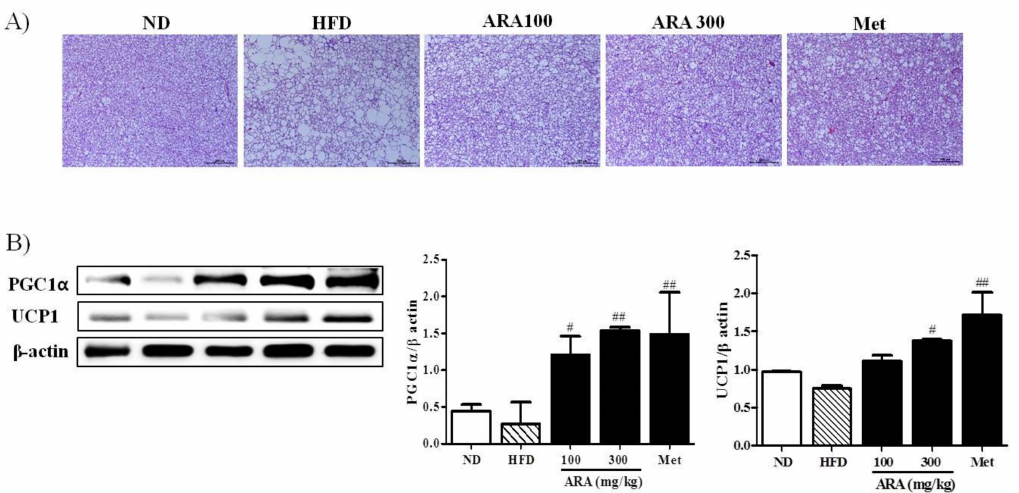
Figure 5. Effects of ARA on energy metabolism in brown fat. ( A ) hematoxylin and eosin staining in brown adipose tissues, original magnification 100 × , Scale bar: 200 µ m; ( B ) PGC1 α and UCP1 protein levels in brown adipose tissues. Results are presented as means ± standard errors of the mean (SEM) ( n = 3). ## p < 0.01, # p < 0.05 versus the high fat diet fed mice (the HFD group). UCP1, uncoupling